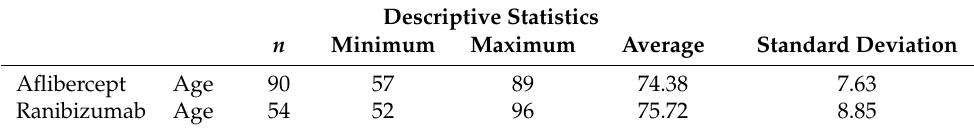
Table 2. Characteristics of the groups in terms of age.